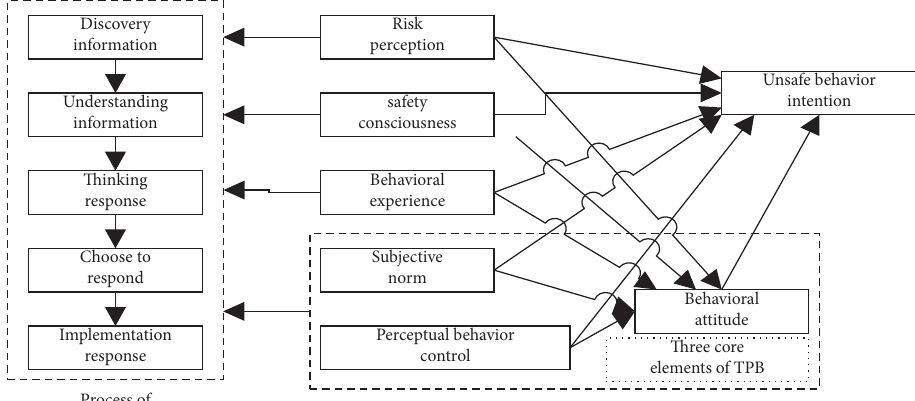
Figure 4: Model for miners’unsafe behavior intention.